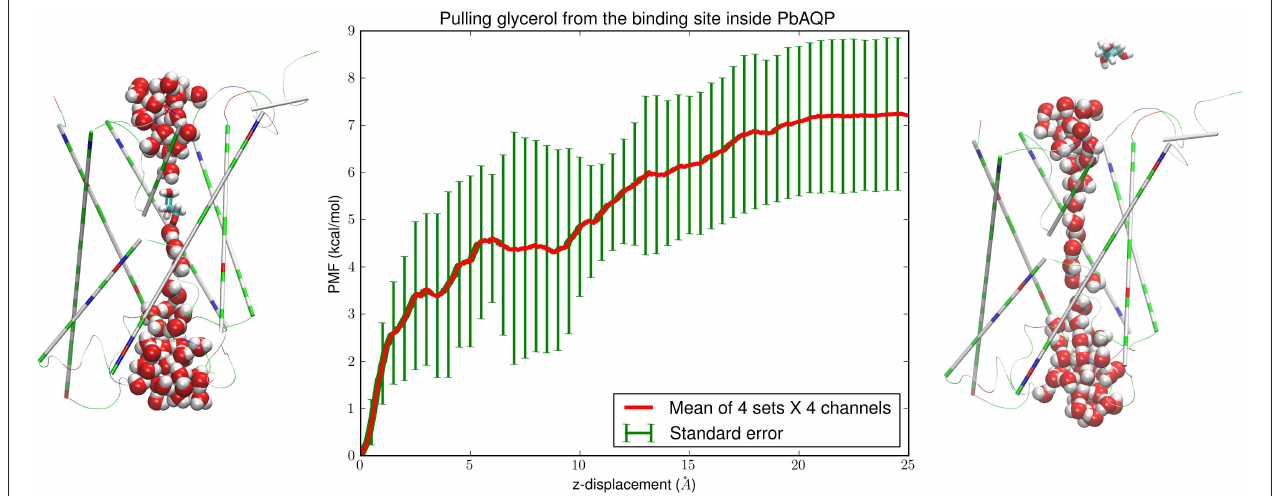
FIGURE 2 | Glycerol-PbAQP interactions. (Left) glycerol bound inside PbAQP near the NLA-NPS motifs interrupts the single file of waters through the channel. (Right) glycerol is held outside the channel and waters line up in single file throughout the channel. The representation and color schemes are identical to Figure 1 except that glycerol is shown in licorices. (Central) the PMF along the dissociation path of glycerol from the binding site to the intracellular side. The mean values and the standard errors are over 16 sets of data (four sets of forward and reverse paths in each of the four channels of the PbAQP tetramer).